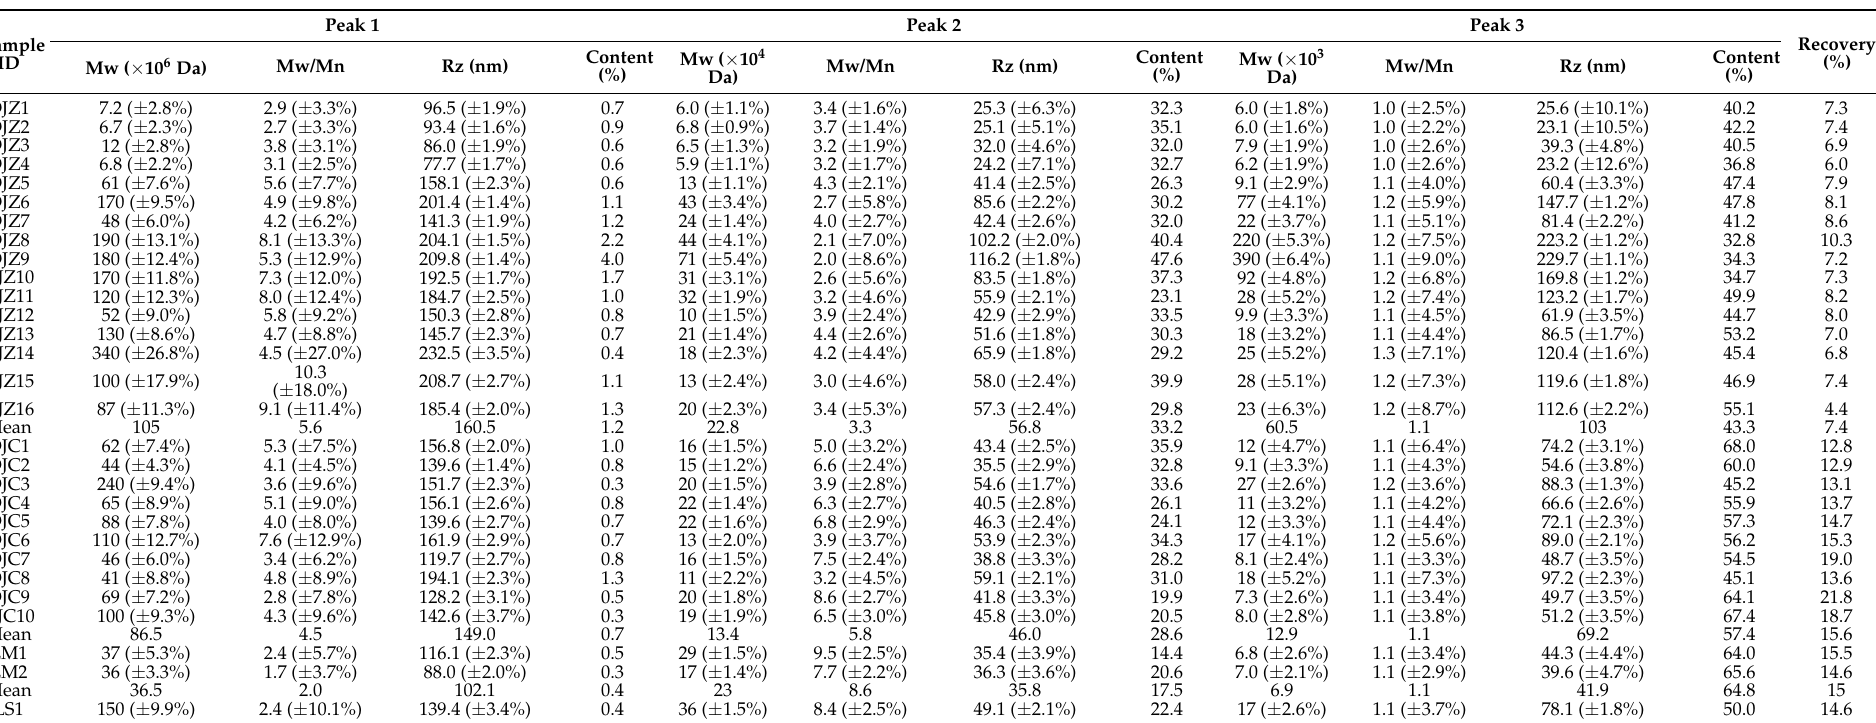
Table 2. The molecular weight (Mw), polydispersity index (Mw/Mn), z-average radius of gyration (Rz), content of different peak (fraction), and yield of polysaccharides from MaiDong of different species or